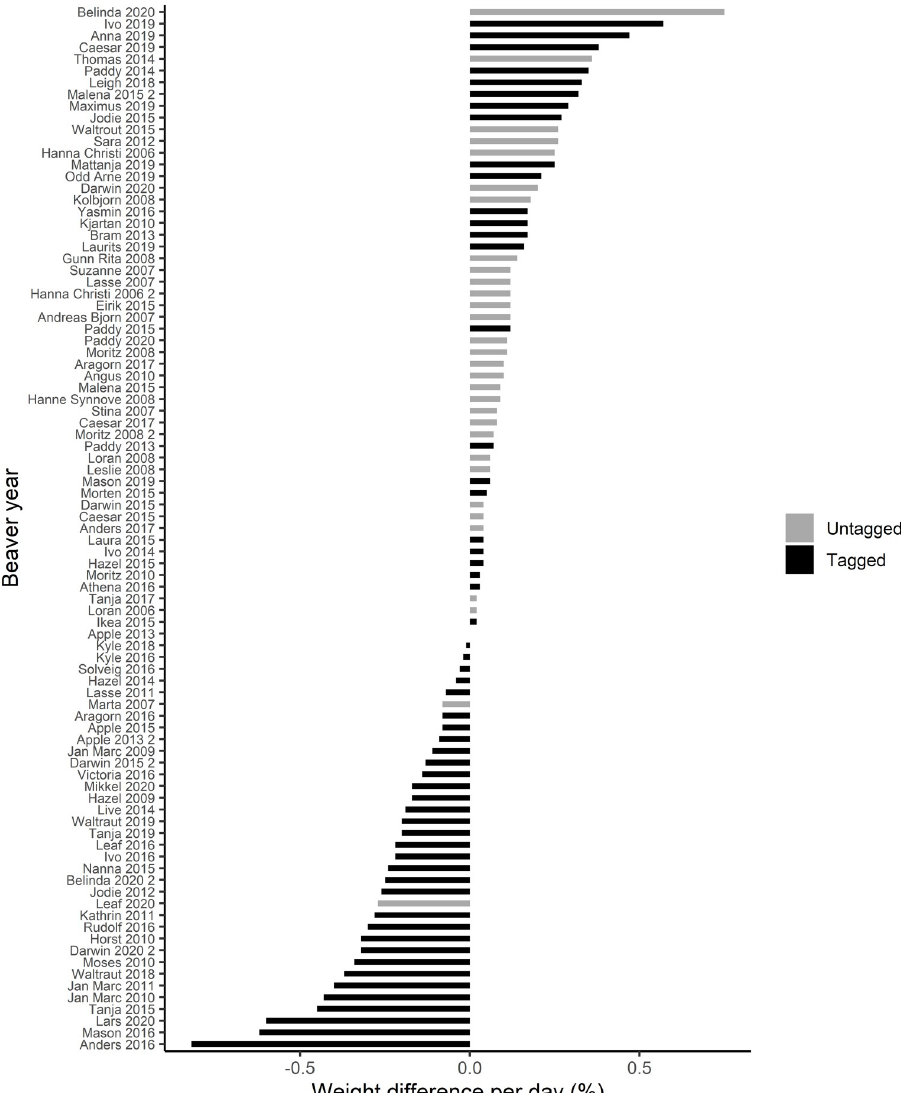
Fig 2. Daily percentage body weight change between captures for Eurasian beavers ( Castor fiber ) in southeastern Norway 2006–2020. Tagged beavers are shown in black while untagged are shown in dark grey. For some beavers, underfur appeared intact, while others had open patches with no underfur remaining.